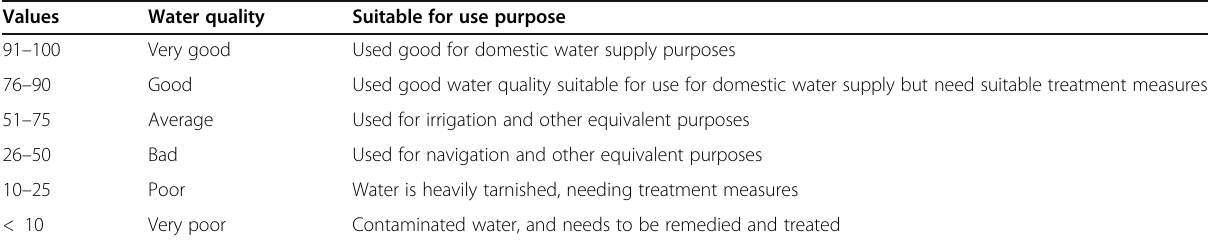
Table 2 The values of WQI and suitable for use purpose Values